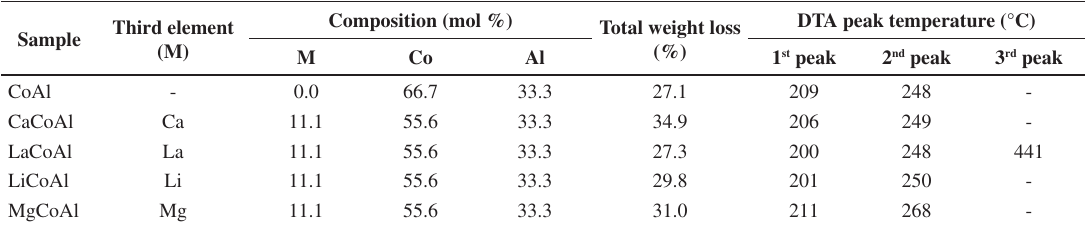
Table 1. Weight loss and DTA data obtained from thermogravimetry for uncalcined samples.